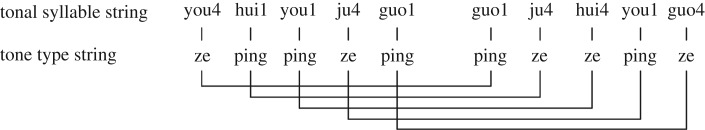
An example of grammatical strings in Experiment 1. As in Jiang et al., the inversion rule used in Experiment 1 was defined over the tones of Chinese language (with respect to the four tones, where tones 1 and 2 are traditionally categorized as ping tones, while tones 3 and 4 are categorized as ze tones). Ten tonal syllables constitute a string and the first five tonal syllables formed the prime, while the last five tonal syllables formed the inversion, which was created by a mapping between the tone type of the tonal syllables (i.e. ping was mapped to ze). For example, if the tone type of the first tonal syllable was ping, then the tone type of the sixth tonal syllable was ze, and if the type of the second tonal syllable was ping, the tone type of the seventh tonal syllable was ze, and so on.